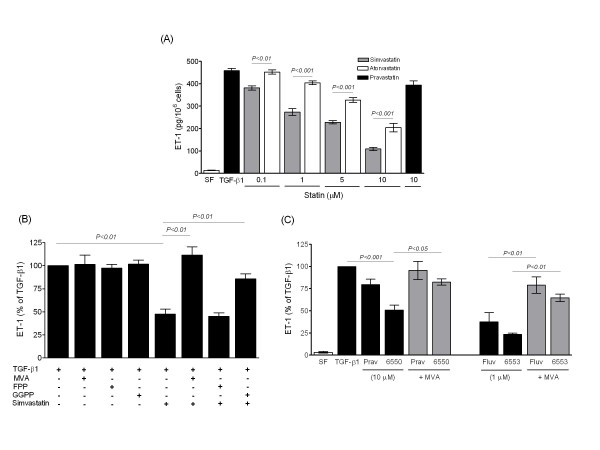
Effect of statins on TGF-β1-stimulated (10 ng/ml) ET-1 release from human PASMCs. (A) Release of ET-1 in conditioned medium was attenuated in a concentration-dependent manner by lipophilic statins, but not by pravastatin, with simvastatin being more potent than atorvastatin. (B) Effect of simvastatin reversed by co-treatment with mevalonate (MVA, 100 μM) or geranylgeranylpyrophosphate (GGPP; 10 μM), but not by farnesylpyrophosphate (FPP; 10 μM). (C) Inhibitory effect of fluvastatin and NO-releasing derivatives of pravastatin (6550) and fluvastatin (6553) also reversed by MVA. Data are mean ± SEM of replicate values (n = 4) from representative IPAH cell isolates and expressed either as the amount of ET-1 detected (per 106 cells) in conditioned medium (A) or as a proportion of that measured in control cells treated with TGF-β1 alone (B-C). SF = serum free untreated cells.